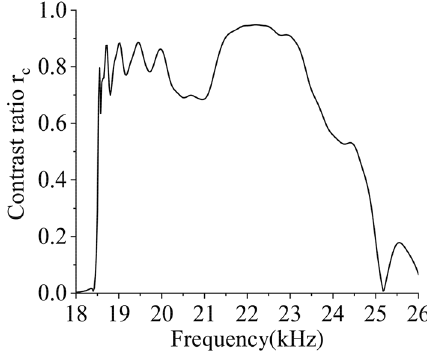
Figure 4. Contrast ratio varies with frequency.